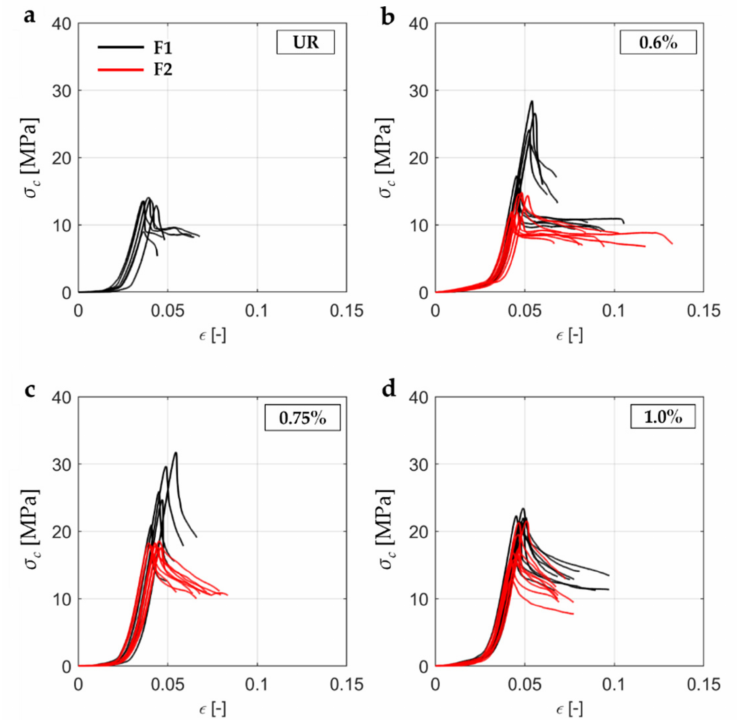
Figure 17. Compressive stress σ c vs. vertical strain ε v in the CTs for: ( a ) un-strengthened case (UR). Strengthened cases for the fibers, F1 and F2, and three fiber contents, F : ( b ) 0.6%; ( c ) 0.75%; ( d )